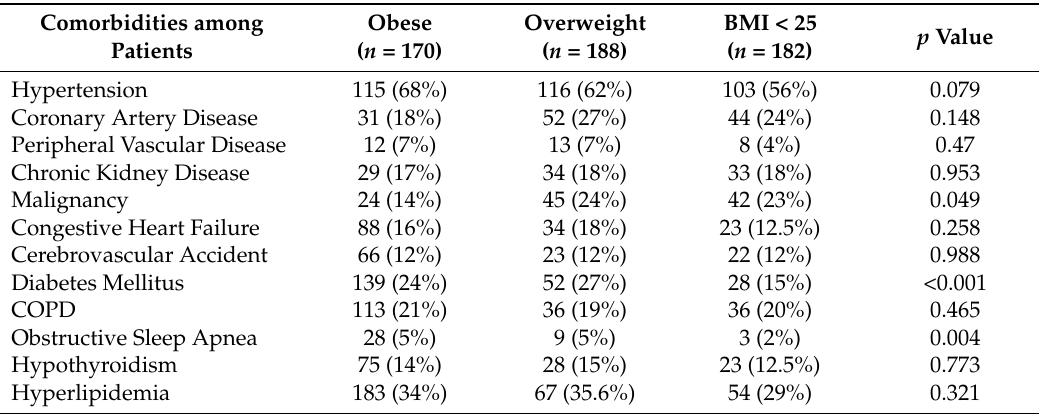
Table 2. Comorbidities among patients ( n =